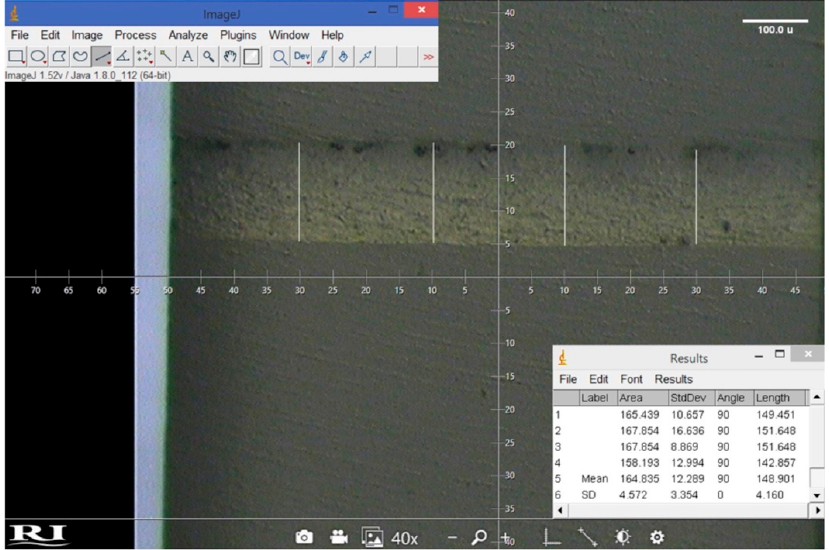
Figure 2. Representative stereomicroscope photo for the evaluation of film thickness (XF 4 mm